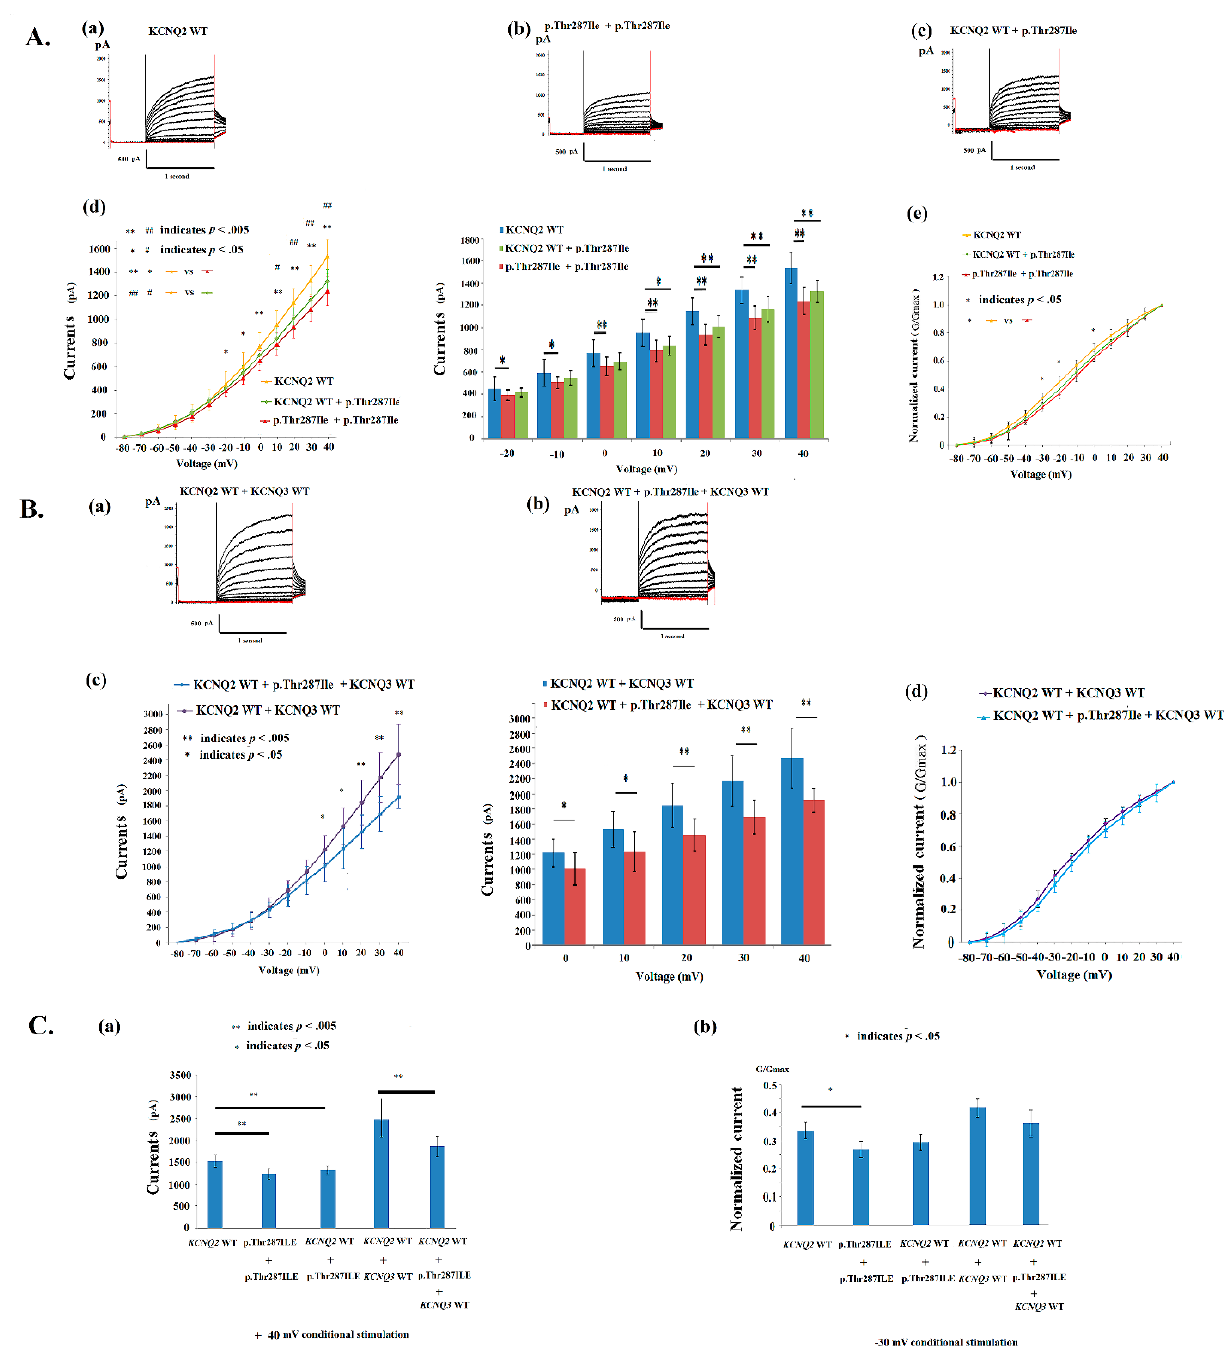
( − 12.2 ± 1.9 mV in homomeric p.Thr287Ile versus − 16.9 ± 2.0 mV in KCNQ2 WT), and K (slope) [8.3 ± 1.3 (mV/e-fold) in homomeric p.Thr287Ile versus 9.5 ± 2.2 (mV/e-fold) in KCNQ2 WT] were lower than those for the WT (Table 2). The conduction curve exhibited a significant impairment in the homomeric p.Thr287Ile channel.